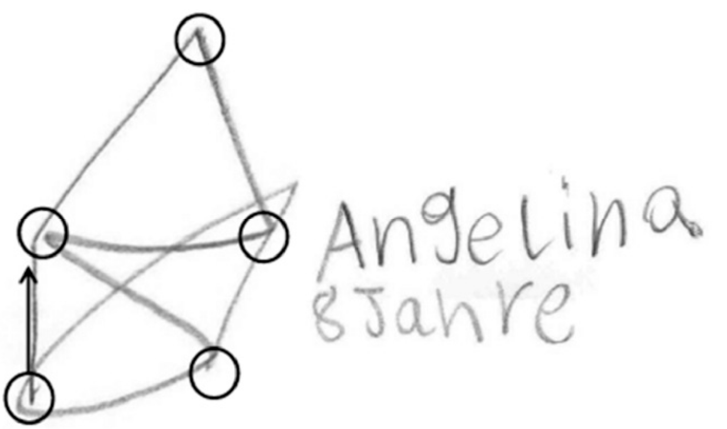
Figure 1. St. Nicolas’ house. Children’s drawing. Nodes are marked by circles. The starting edge is highlighted by arrow.